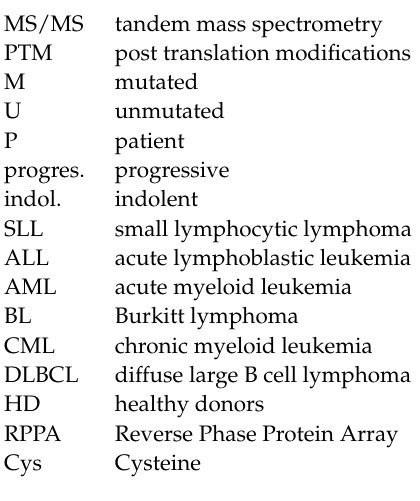
examined. Table S3c. Repurposed drugs for CLL prognosis. Table S3d. Repurposed drugs for CLL diagnosis. Table S3e. Proteomics data in CLL slim